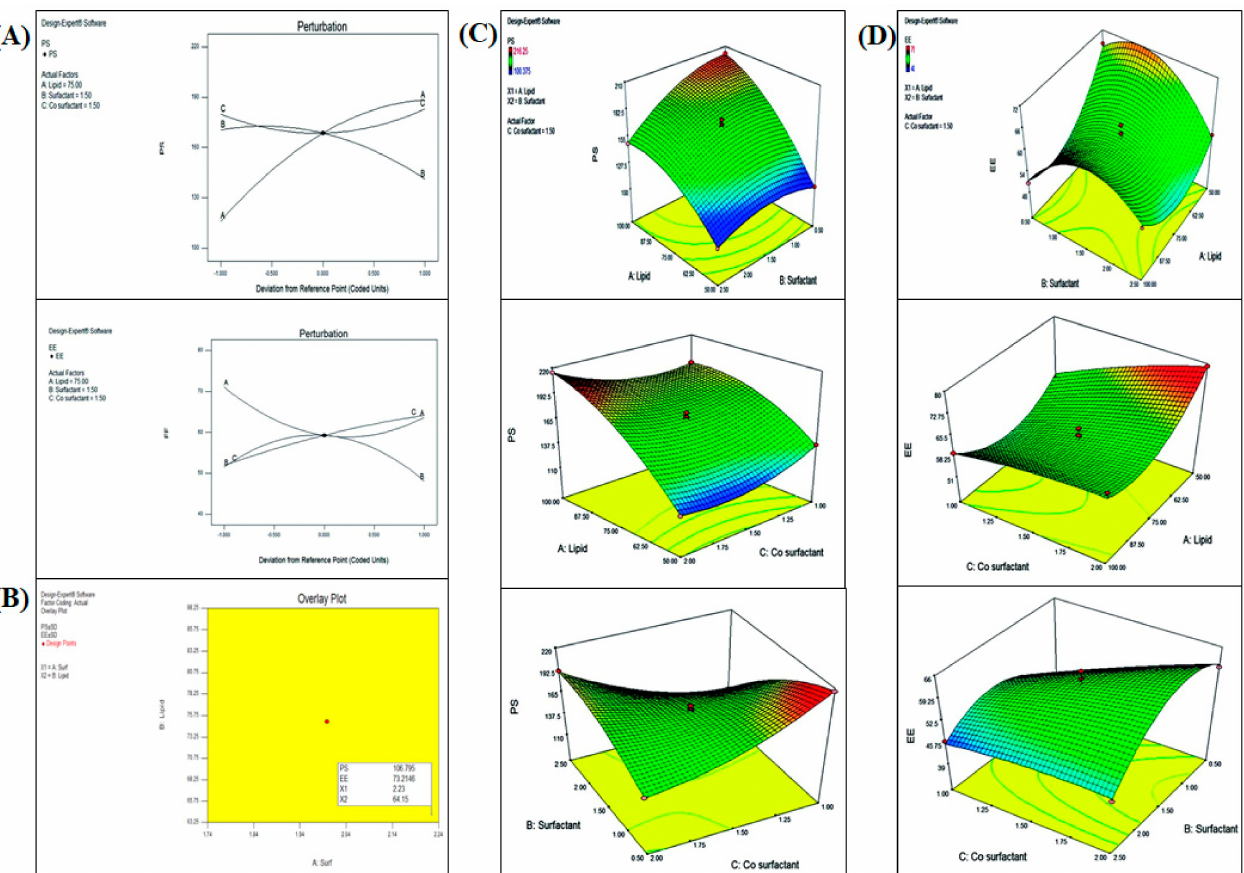
Figure 2. ( A ) Perturbation plot depicting the effects of solid lipid, surfactant, and co-surfactant on PS and %EE. ( B ) Overlay plot of the BBD model for the DSTA-SLNs. ( C ) Response surface plots of PS, indicating the effects of lipid, surfactant, and co-surfactant. ( D ) Response surface plots of %EE, indicating the effects of lipid, surfactant, and co-surfactant.